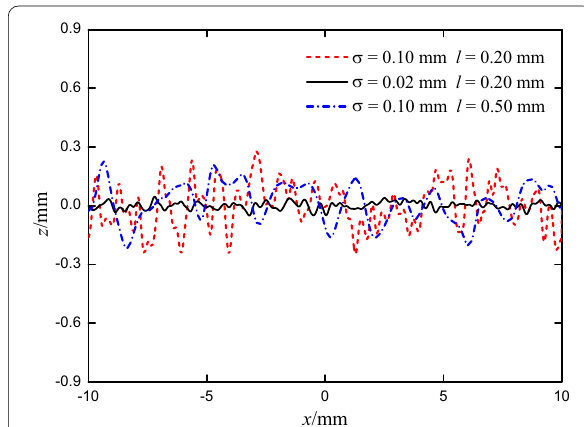
Figure 1 Partial features of rough surfaces with different